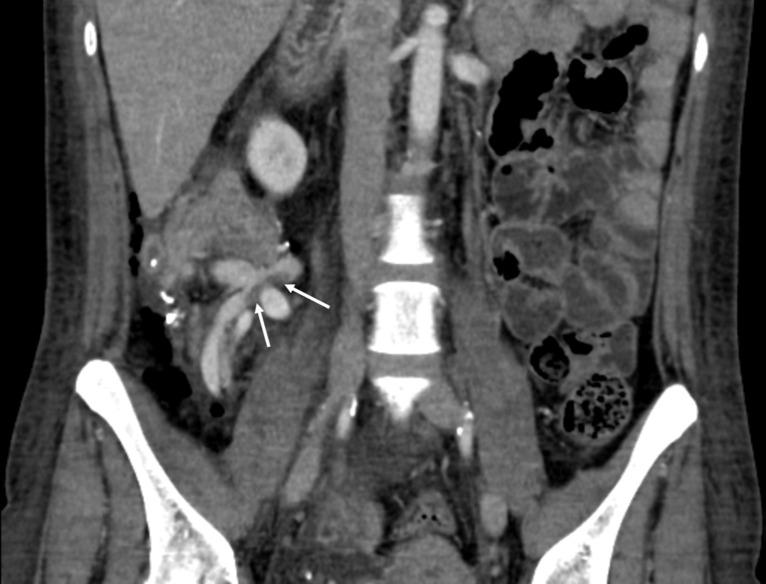
Thrombus on CT scan.Computed tomography scans with intravenous contrast in venous phase of a pancreas transplanted patient showing a thrombus in the portal segment of the graft vein.